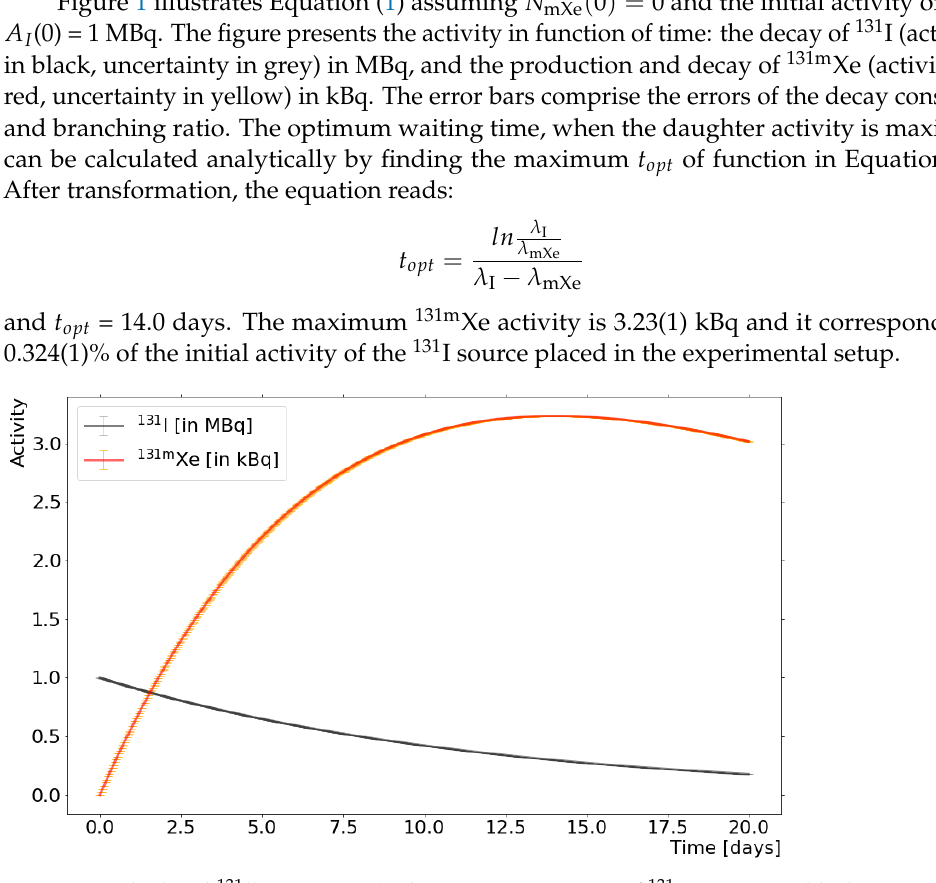
Figure 1. Calculated 131m Xe activity (red) vs. time. A source of 131 I (activity in black, uncertainty in grey) decays into 131m Xe (activity in red, uncertainty in yellow), which itself decays into 131 Xe (stable, not shown). The error bars comprise the errors of the decay constant and branching ratio. The maximum activity plateau for 131m Xe is at day 14 (Equation